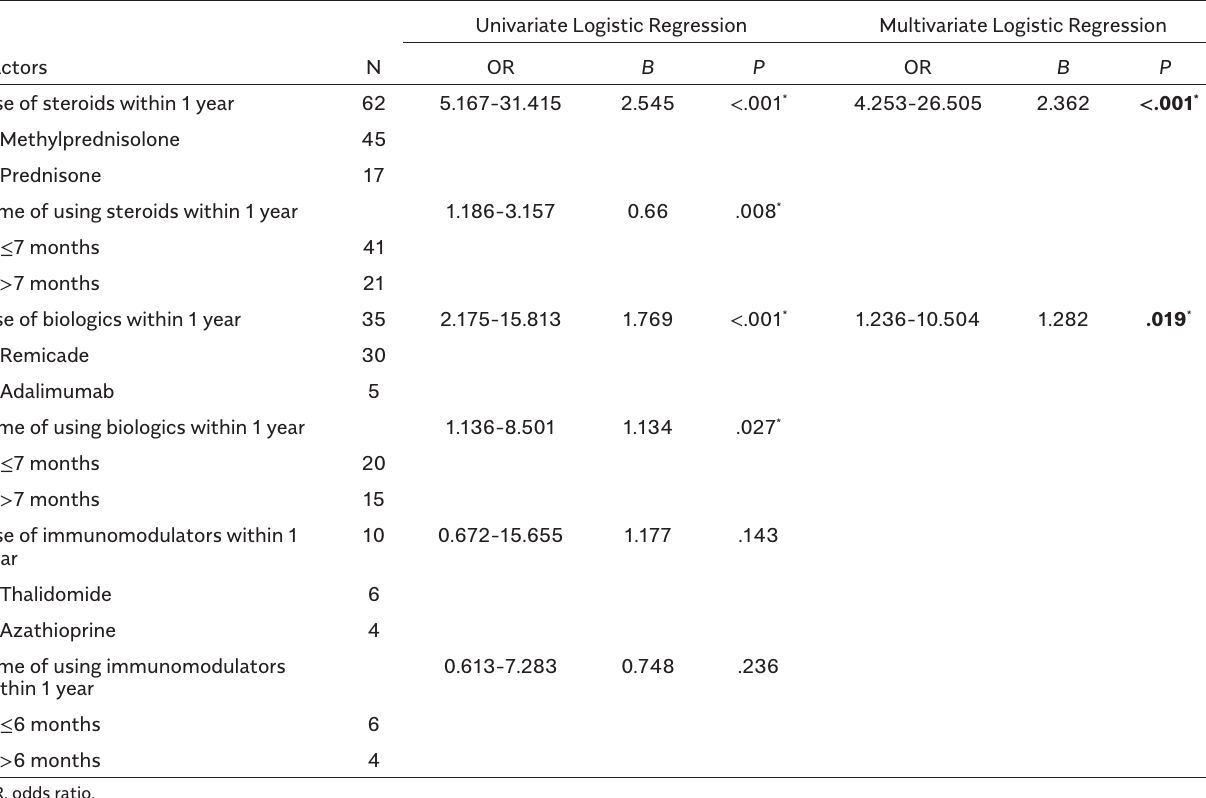
Table 3. Univariate and Multivariate Logistic Regression of Using of Steroids or Biologics or Immunomodulators Within 1 year on Low Muscle Mass Univariate Logistic Regression Multivariate Logistic Regression Factors N OR B P OR